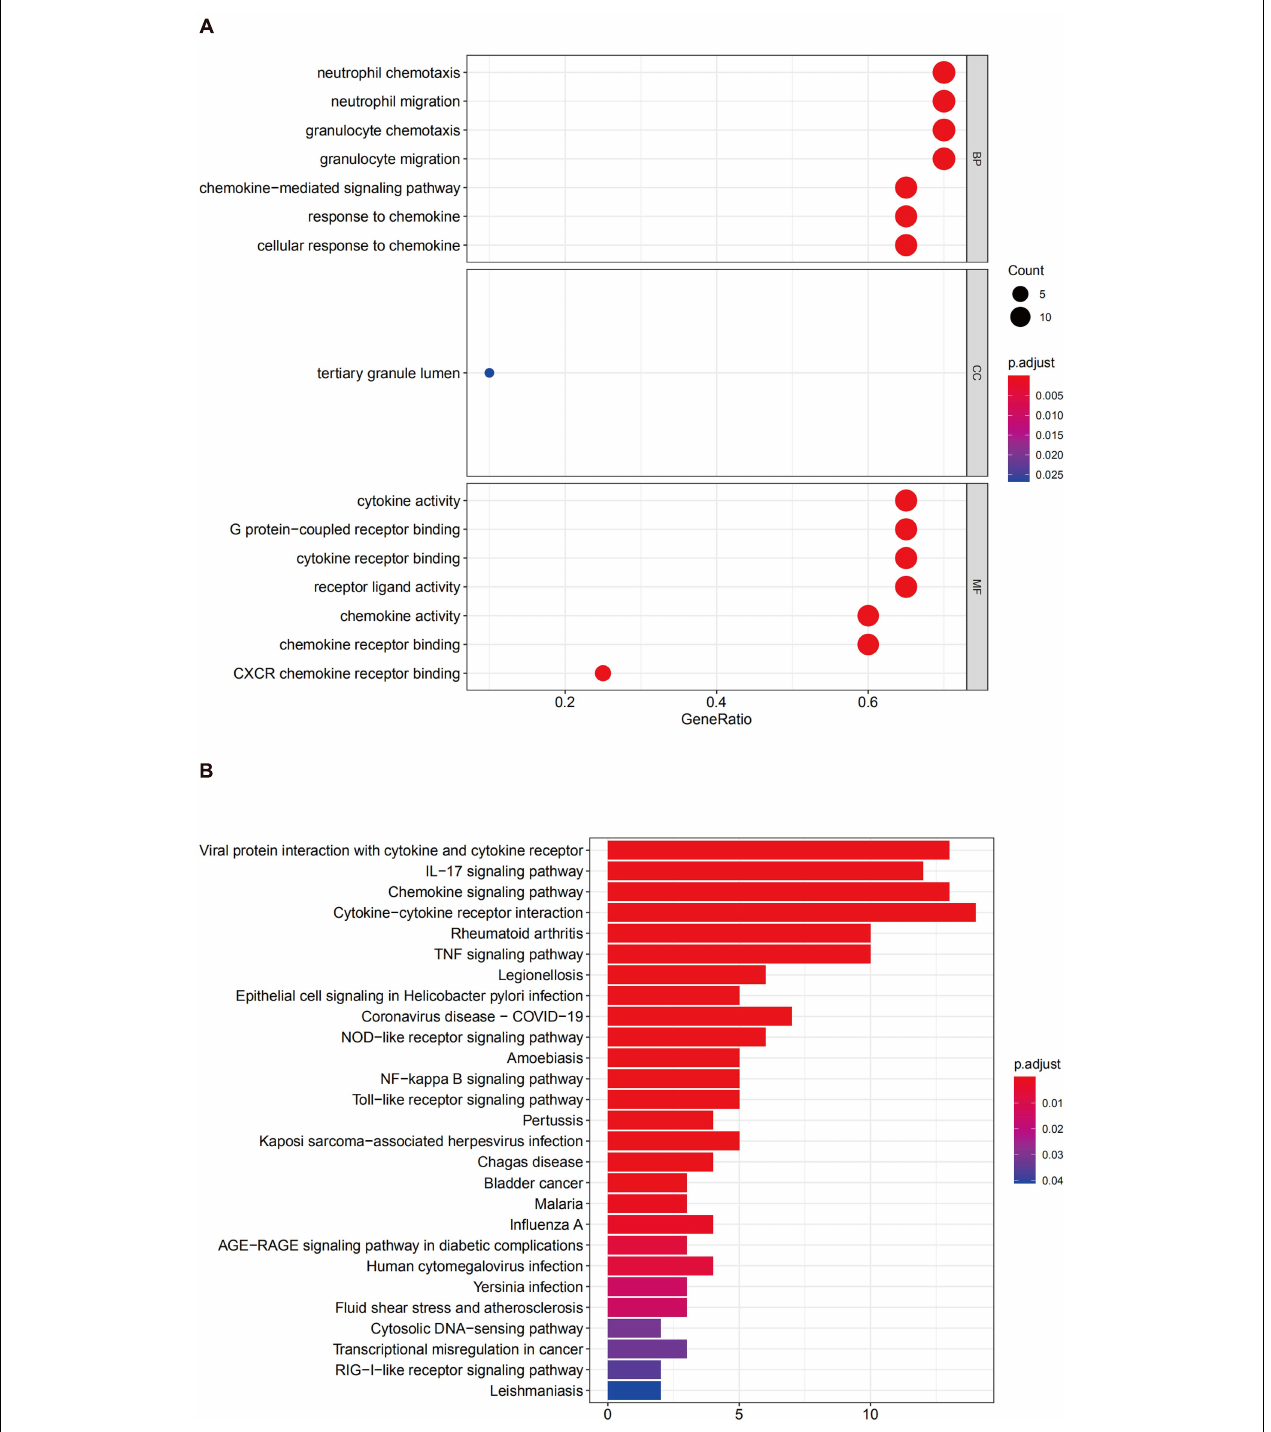
FIGURE 7 | Functional enrichment analysis for the genes in module 1 (A) GO analysis for DEGs. (B) The KEGG analysis for DEGs.